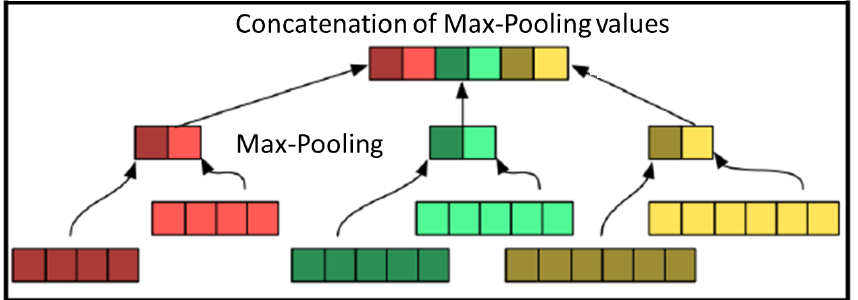
Figure 4. The max-pool operator: The maximal value of each vector in the left is selected and concatenated in a new layer denoted as the “Max-pooling” layer (right most vector).